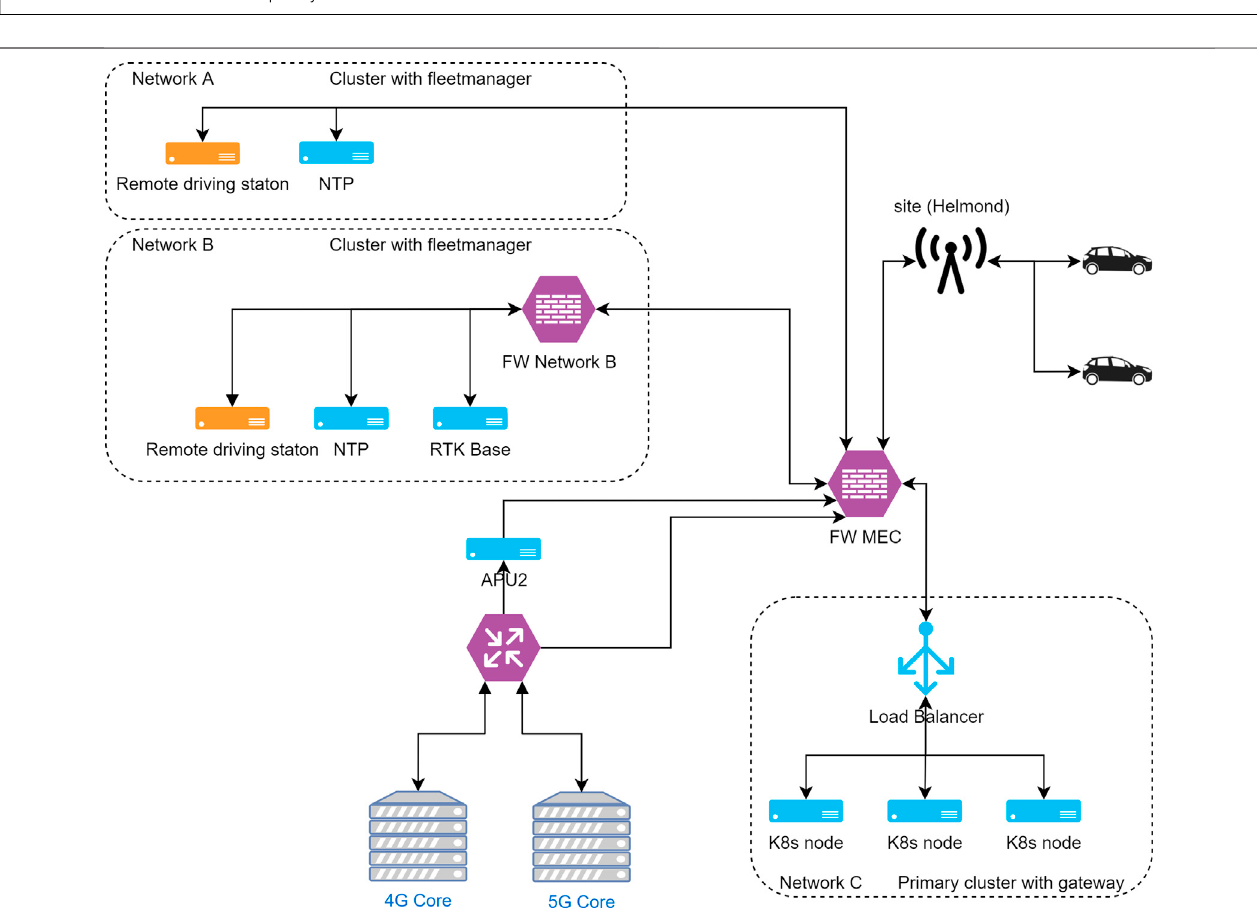
interconnectthevehicleswiththeremotedrivingstations, running onaseparate clusterconnectedtotheremotedriving.Each remotestation hasits own fl eet manager, to enable easy switching between the two vehicles.